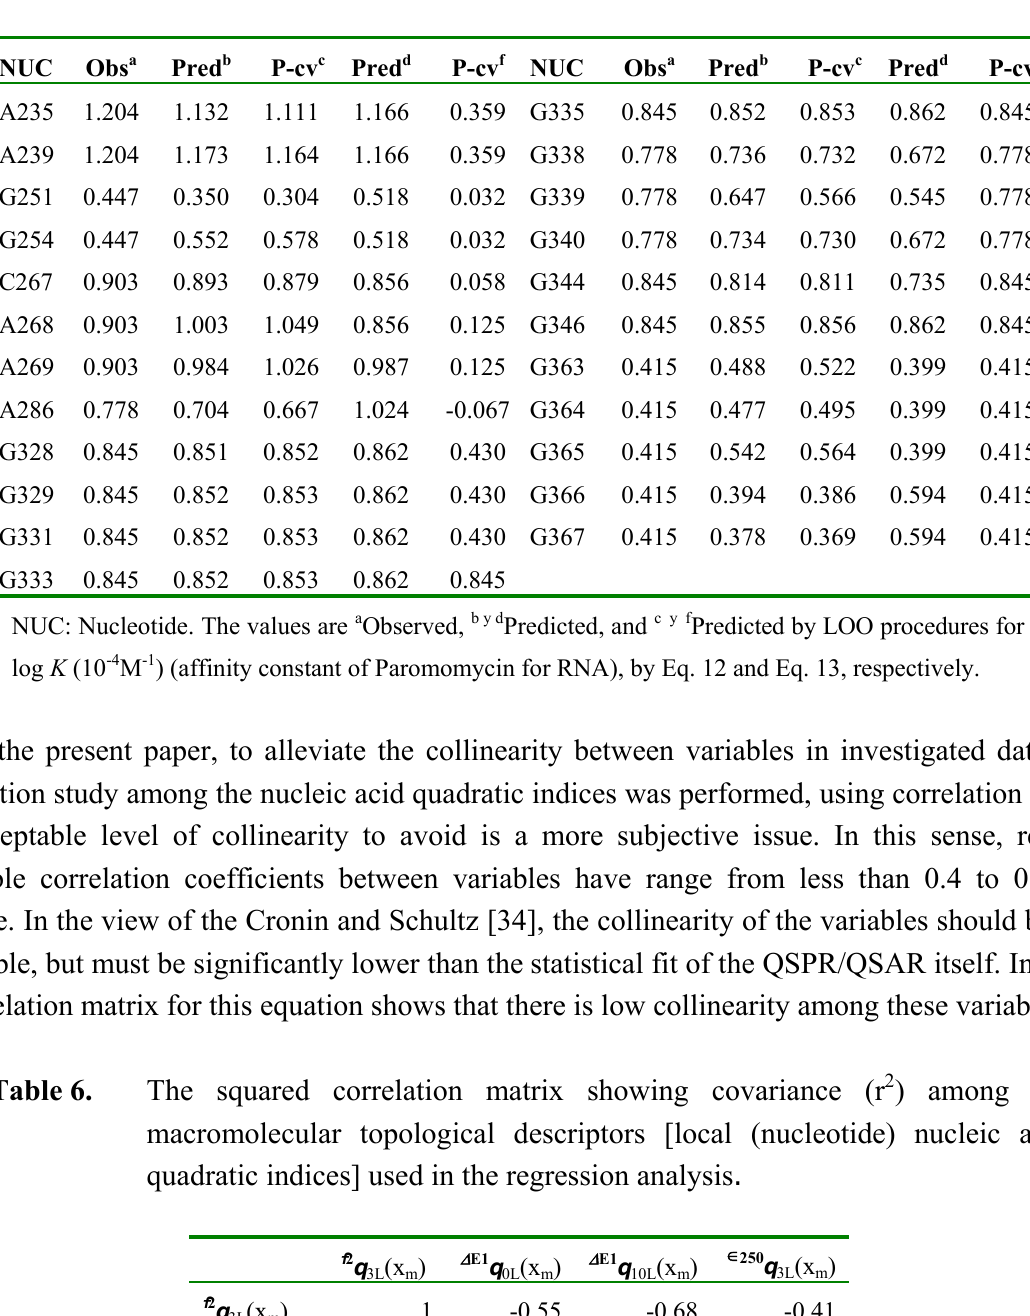
Table 5. Observed, predicted and predicted (alter LOO cross-validation procedures) values of Log K obtained from Eq. 11 and Eq. 12.